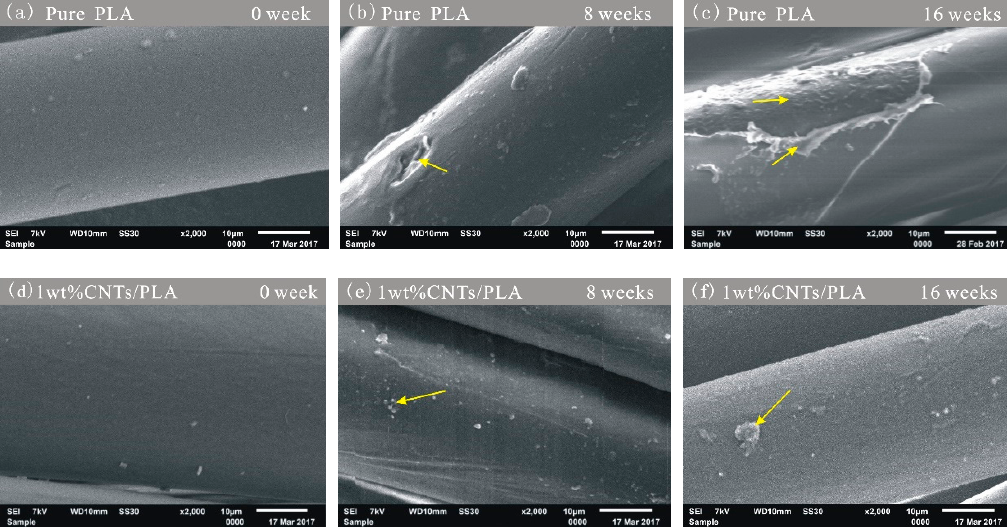
Figure 5. SEM images of surface morphology of sutures at different degradation time points: ( a ) pure PLA suture degraded for 0 week, ( b ) pure PLA suture degraded for 8 weeks, ( c ) pure PLA suture degraded for 16 weeks; ( d ) 1wt% CNTs/PLA suture degraded for 0 week, ( e ) 1wt% CNTs/PLA suture degraded for 8 weeks, ( f ) 1wt% CNTs/PLA suture degraded for 16 weeks.